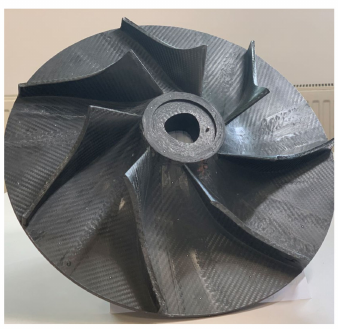
Figure 17. Composite centrifugal compressor impeller after